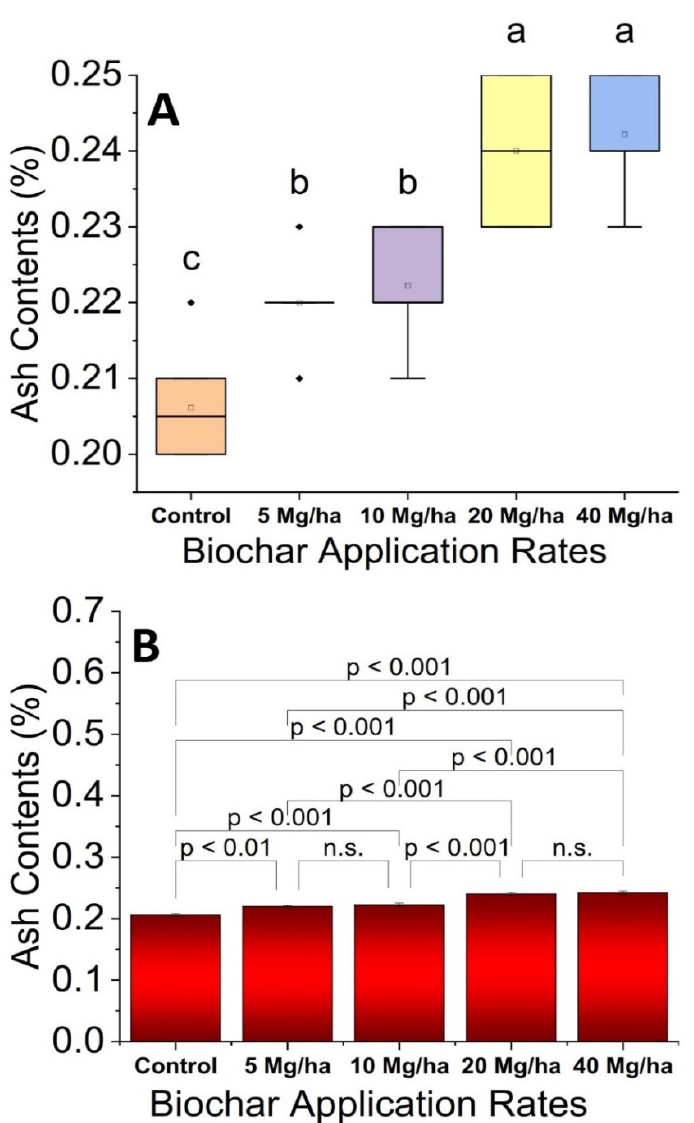
Figure 7. Effect of different biochar application rates on mango fruit ash contents. Bars are mean of 9 replicates. Different letters show a significant difference at p ≤ 0.05 ( A ). Probability value hierarchy for fruit ash contents is provided in ( B ).